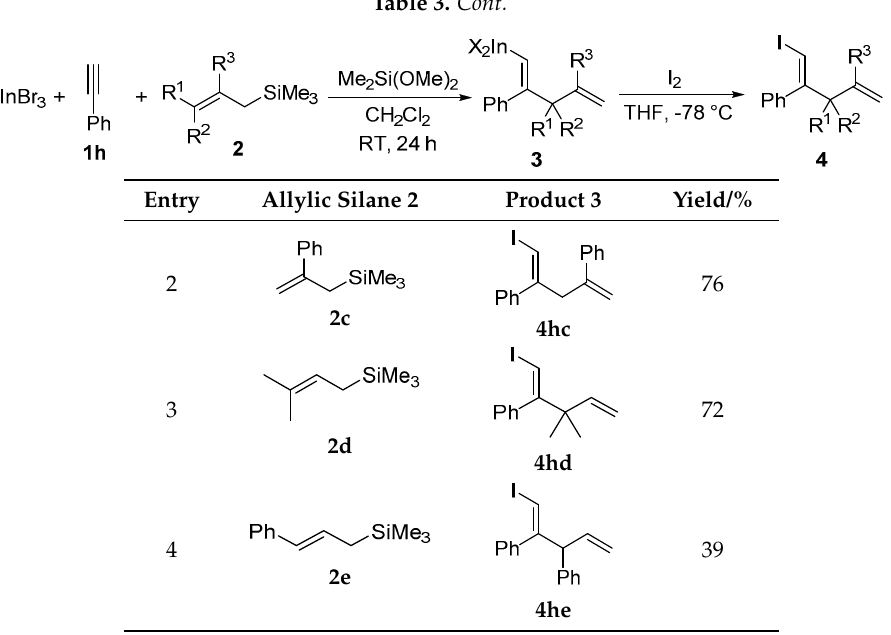
Table 3. Scope of allylic silane 2 in allylindation a . Table 3. Cont.